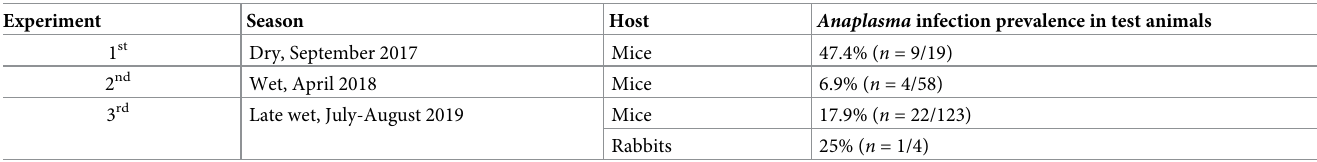
Table 2. Summary of Anaplasma infection in test mice and rabbits.